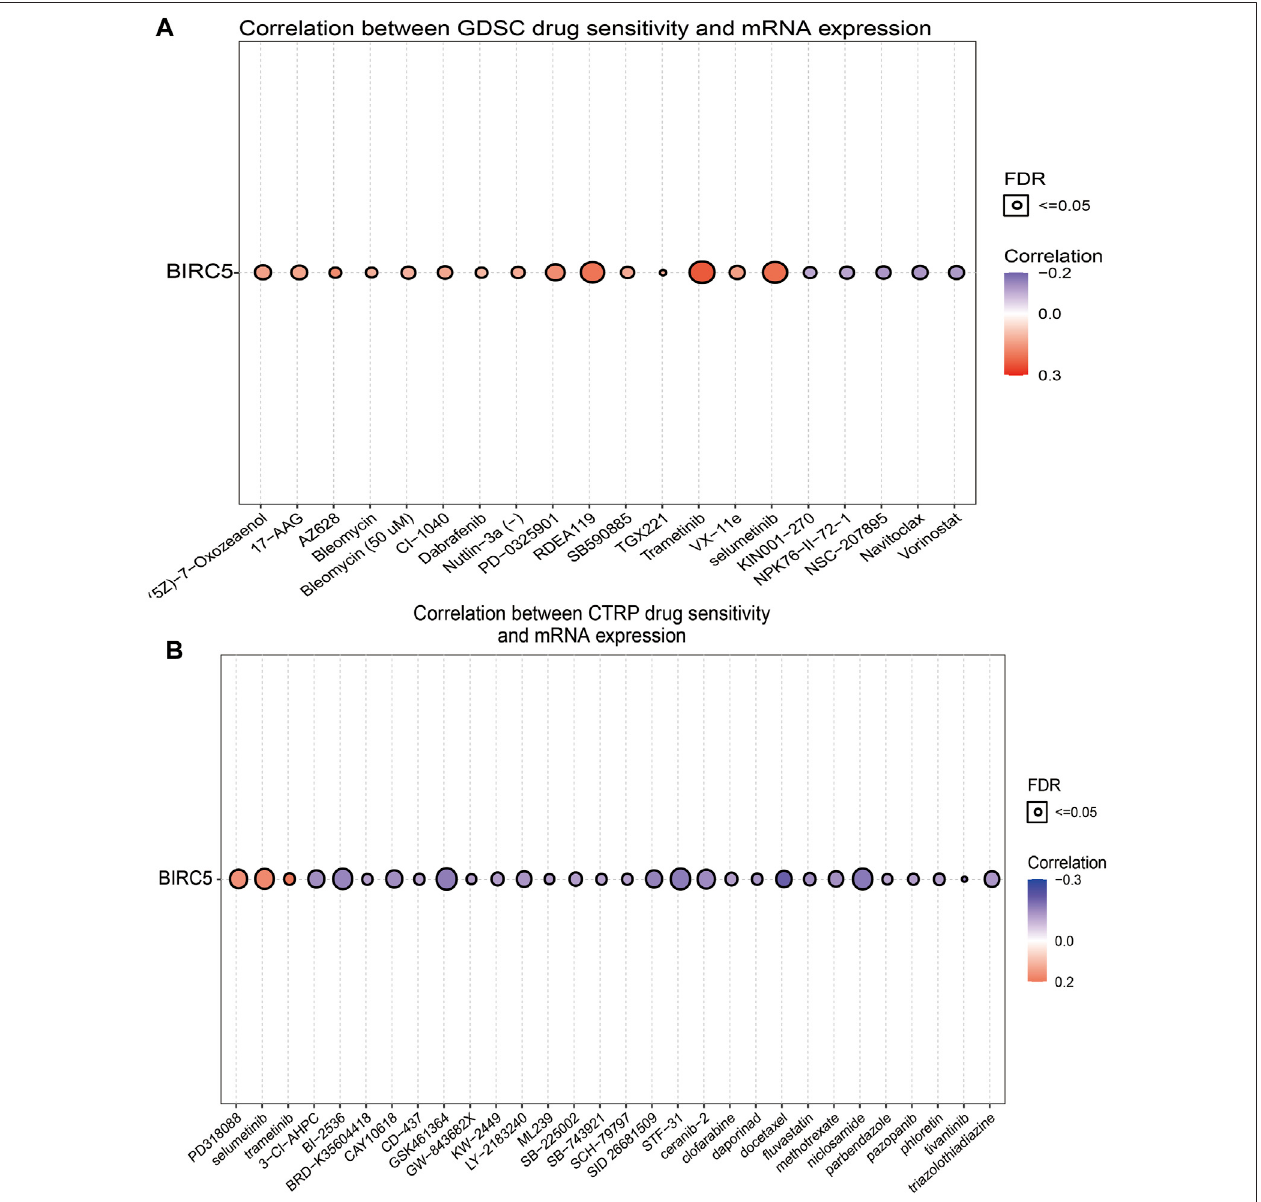
FIGURE 9 | Correlation between drug sensitivity and BIRC5 expression. (A,B) The correlation between BIRC5 expression and drug sensitivity in pan-RCC was studied bySpearmancorrelationanalysis.Redrepresentspositivecorrelationbetweendrugssensitivityand BIRC5 expression,andbluerepresentsnegativecorrelation between drugs sensitivity and BIRC5 expression. (A) : GDSC, (B) :